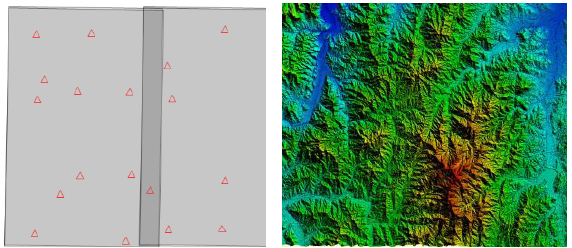
Figure 3. Distribution of GCPs (left) and overview of the reference DEM with color-coded elevations